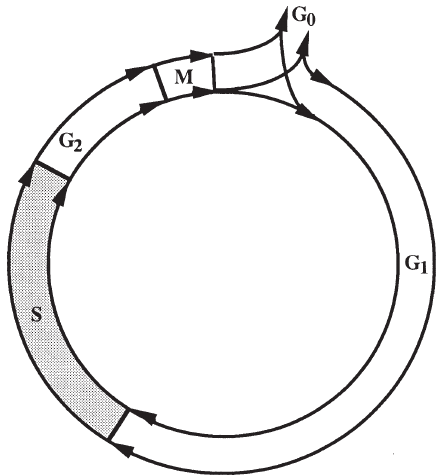
Fig. 1. Schematic representation of the cell cycle. After the M phase which consists of nuclear division (mitosis) and cytoplasmic division (cytokenesis) the daughter cells begin the interphase of a new cycle. Interphase starts with the G 1 phase (gap period). The S phase begins when DNA synthesis starts and ends when the DNA content of the nucleus has doubled. The cell then enters the G 2 phase which ends when mitosis starts. Each daughter cell can shift to a quiescent state G 0